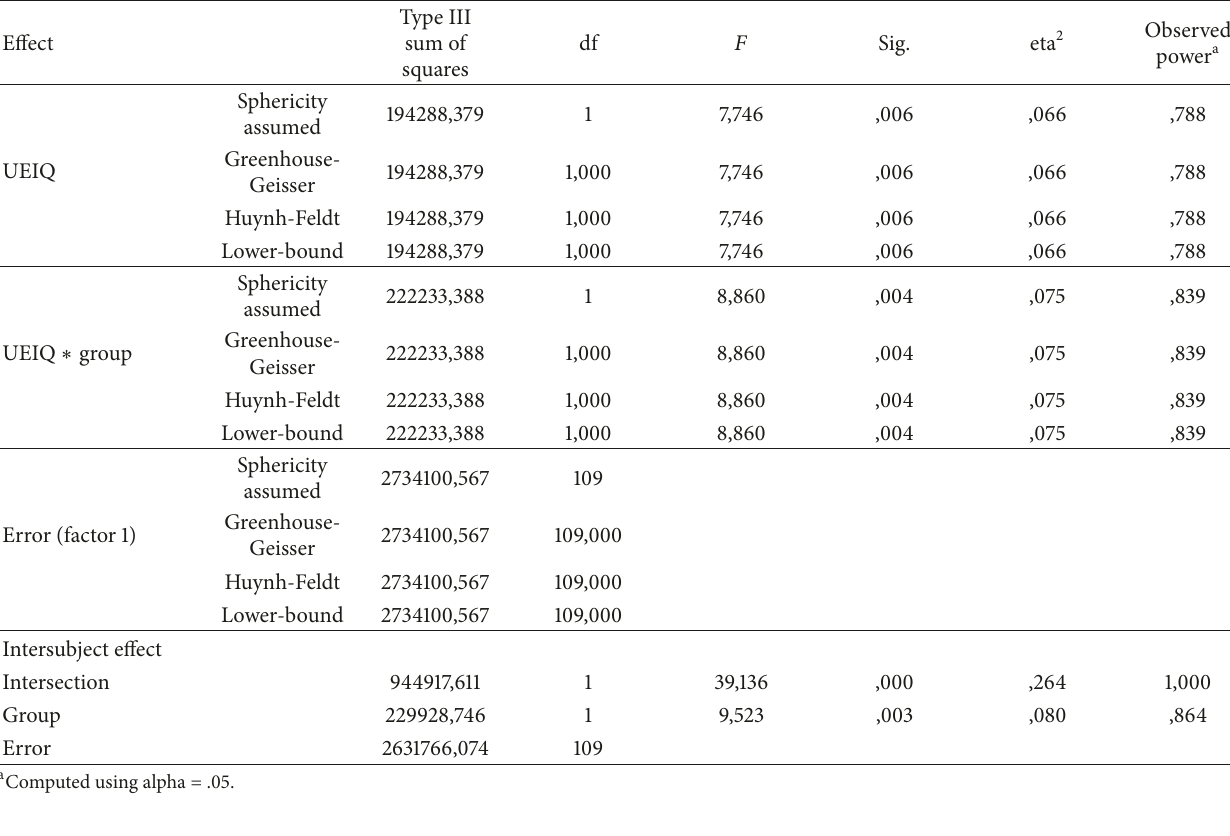
Table 6: UEIQ intrasubject and intersubject effects.